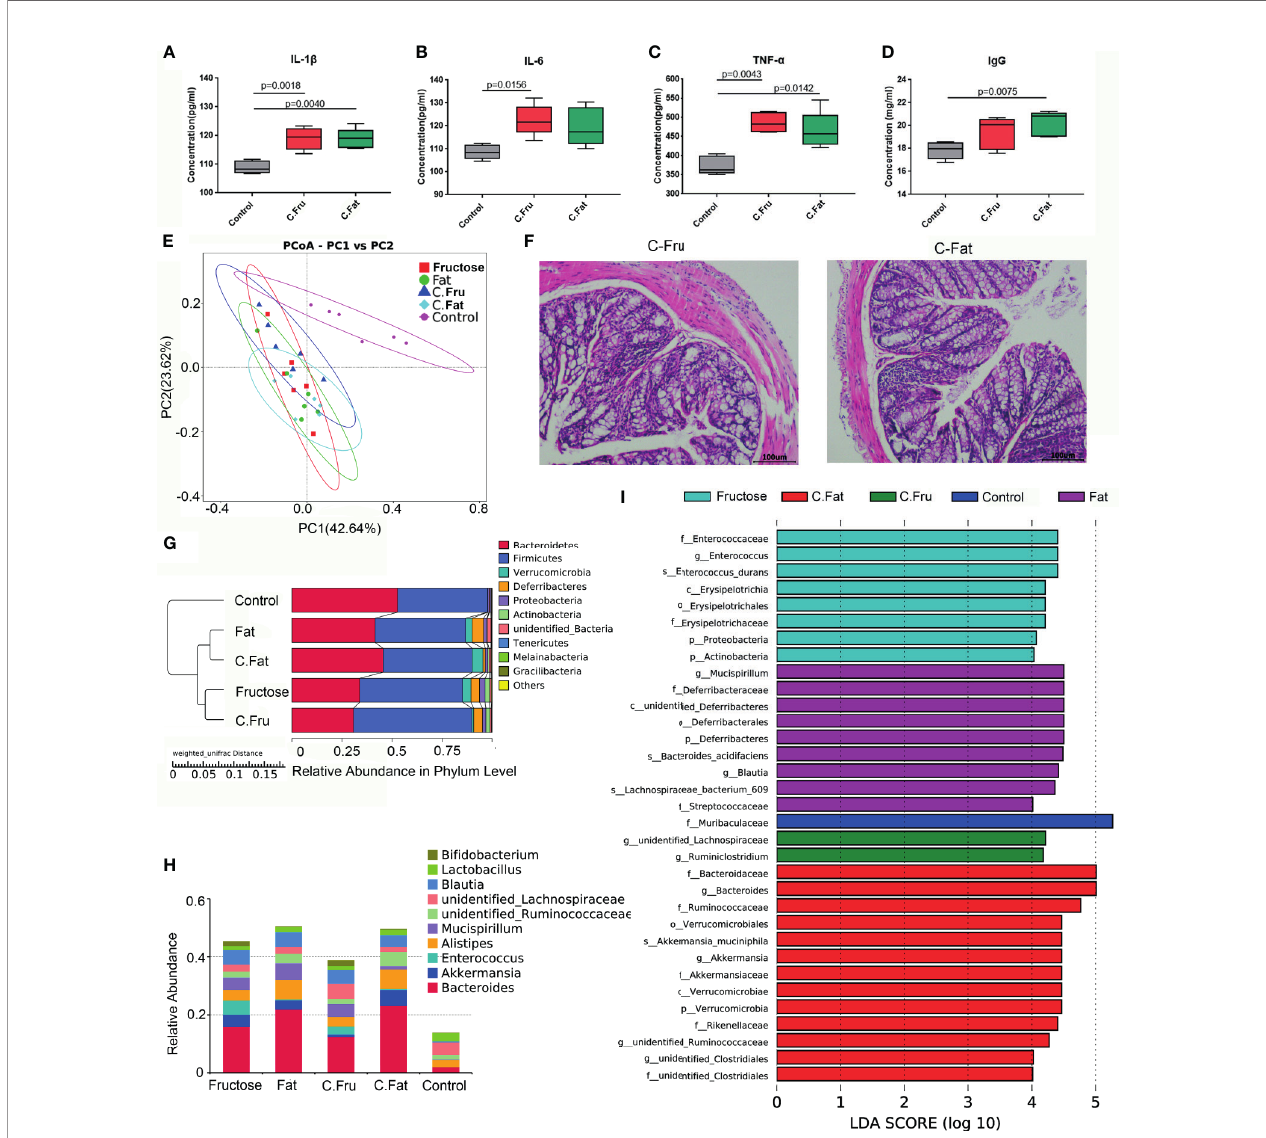
FIGURE 5 | Fecal bacteria transplantation changes the intestinal microbiota and induces in fl ammation. Serum immune factors, including IL-1 b (A) , IL-6 (B) , TNF – a (C) , and immunoglobulin IgG (D) associated with in fl ammation. In the PCoA analysis, the abscissa and ordinate, respectively, represent a principal component, and percentage represents the contribution value of the principal component to the sample difference (E) . H&E staining showing the intestinal state of the experimental group after transplantation of fecal bacteria (F) . The UPGMA cluster tree, on the left is the UPGMA cluster tree structure, and on the right is the relative abundance distribution map of species at the phylum level (G) . Histogram of species distribution at the genus level (H) . The histogram of LDA value distribution shows the species with signi fi cant differences in abundance among the different groups (I) . (C.Fru: mice transplanted with fecal bacteria from the high-fructose group, C.Fat: mice transplanted with fecal bacteria from the high-fat